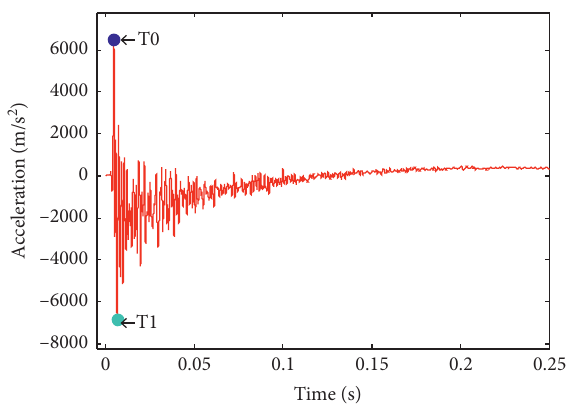
Figure 9: Signal of trend term not